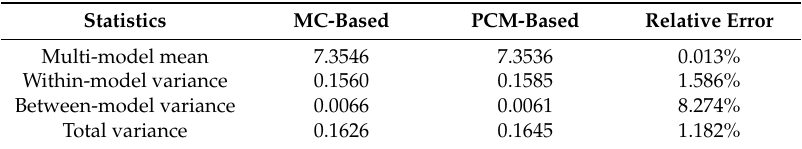
Table 2. Setting of the synthetic test to implement multi-model analysis.